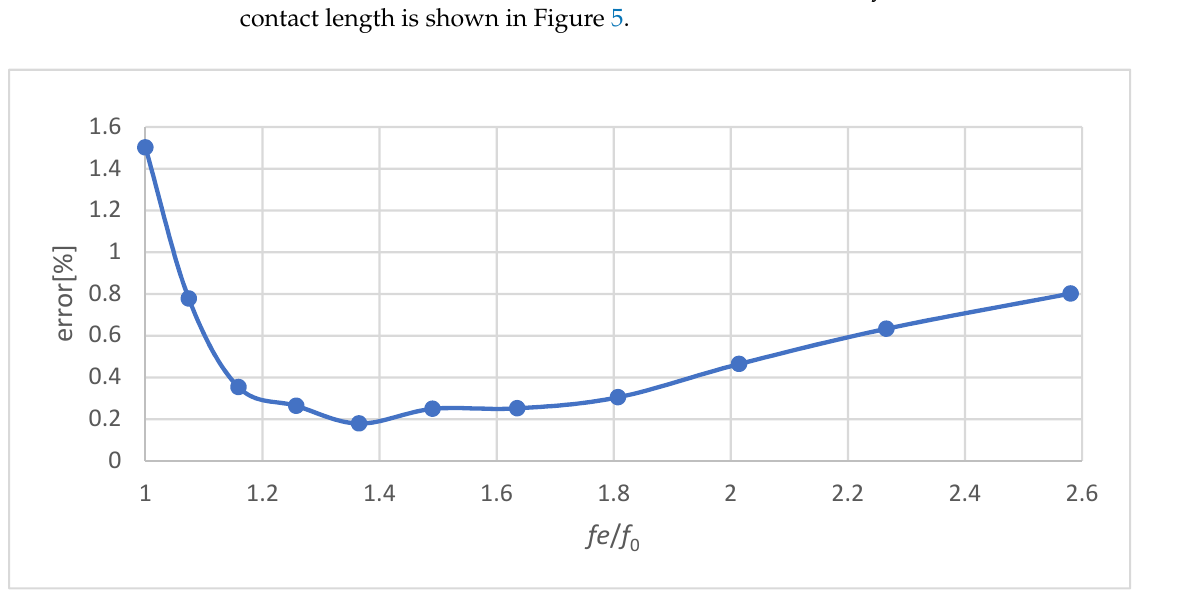
Figure 5. Error visualization of non-linear dynamics resonance frequencies and estimated with the presented formula.